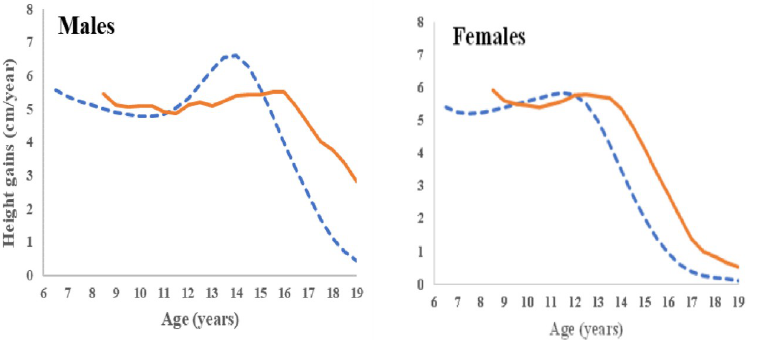
Fig 2. Mean height gain over time (in cm/year) for males and females (orange continuous line = participants, blue dotted line = WHO reference population).